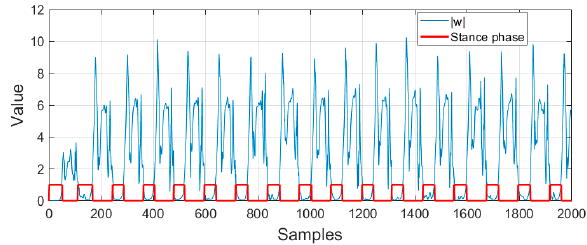
Figure 7. Result of implemented stance phase detection.